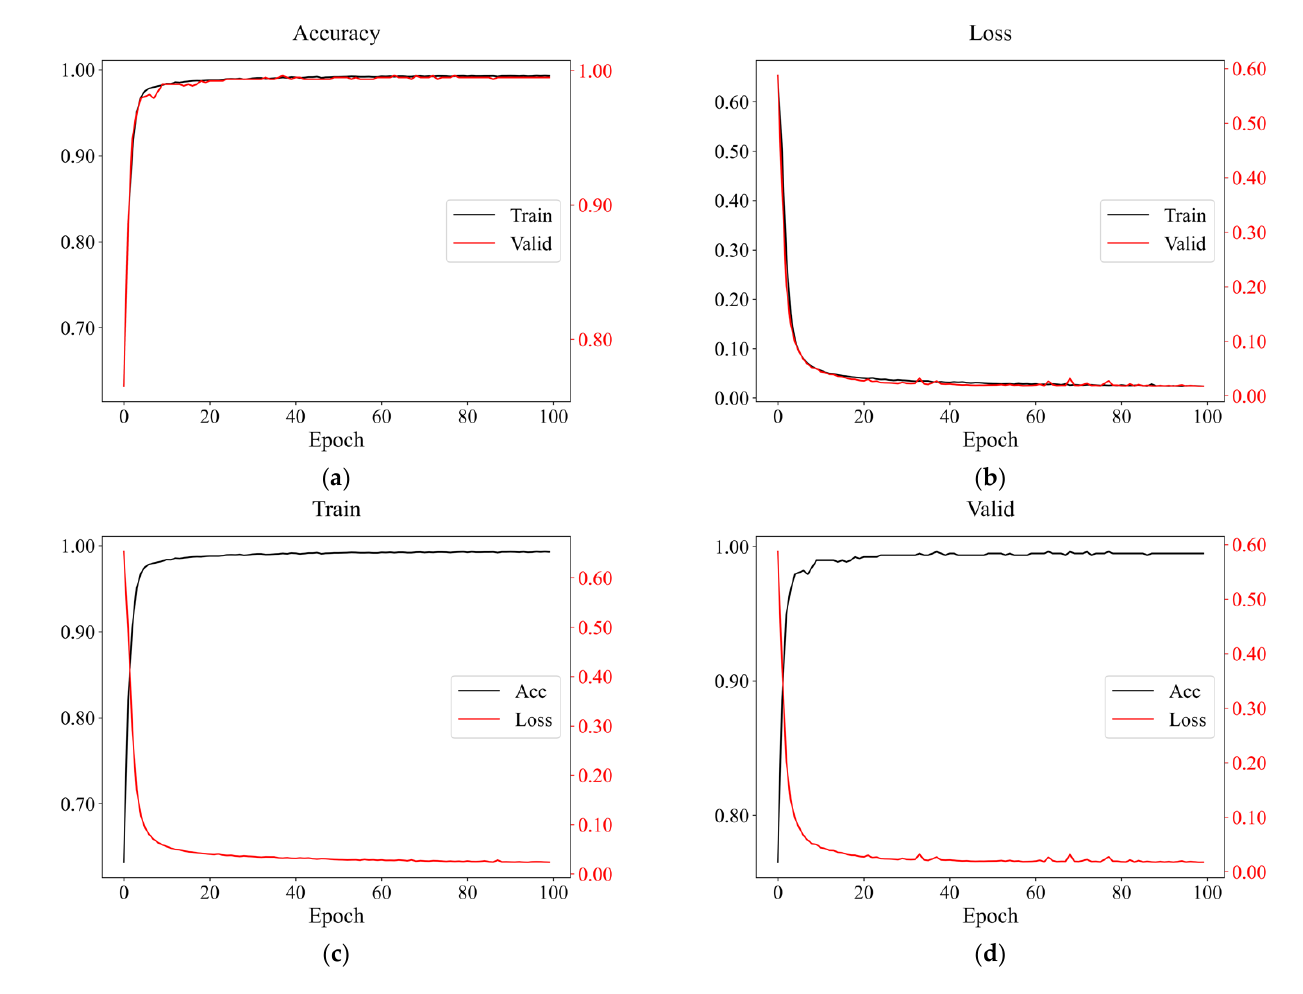
Figure 10. An example of resulting curves of CNN when K = 2. ( a ) The accuracy and ( b ) loss curves of the training and validation set; the accuracy and loss curves of ( c ) the training and ( d ) validation set.